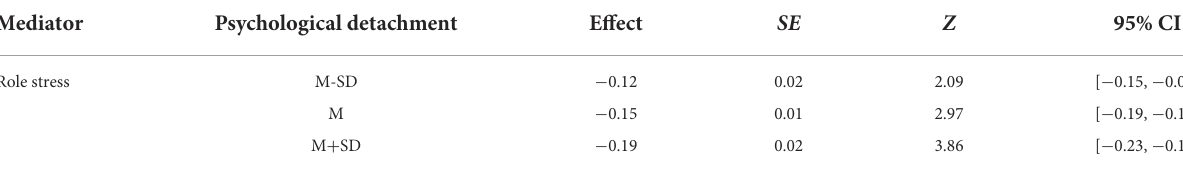
TABLE 4 Conditional indirect effect of psychological detachment when role stress was mediated between empowering leadership and work–family